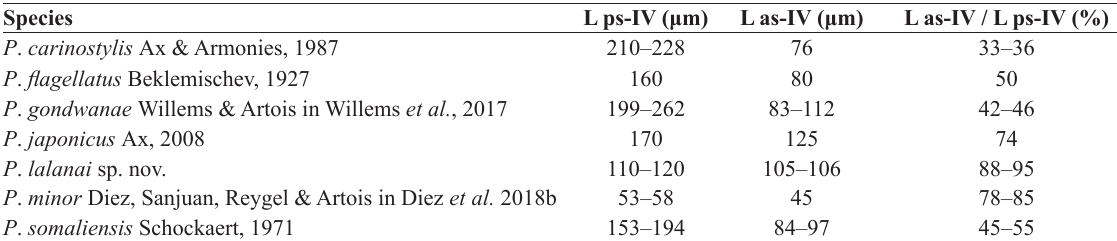
Table 2. Comparison of the longitudes and proportions among the stylets of species of Phonorhynchoides . Abbreviations: see Table 1; as-IV = accessory stylet